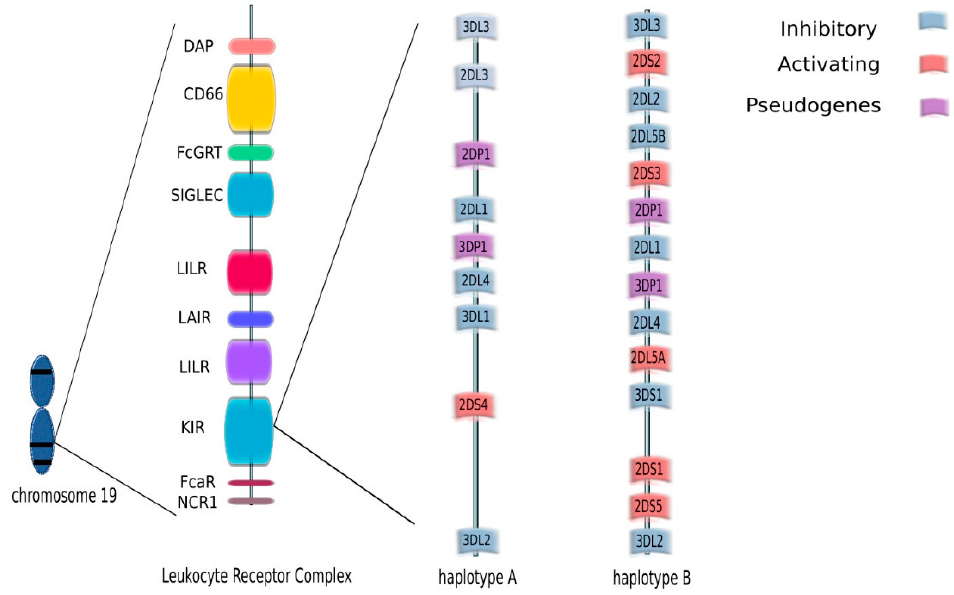
Figure 2. KIR genes are located on chromosome 19, in the leukocyte receptor complex (LRC). The KIR gene family consists of 15 gene loci (KIR2DL1, KIR2DL2/L3, KIR2DL4, KIR2DL5A, KIR2DL5B, KIR2DS1, KIR2DS2, KIR2DS3, KIR2DS4, KIR2DS5, KIR3DL1/S1, KIR3DL2, KIR3DL3) and two pseudogenes (KIR2DP1 and KIR3DP1.) KIR genotypes can be divided into two haplotypes: A and B depending on the composition of their genes.